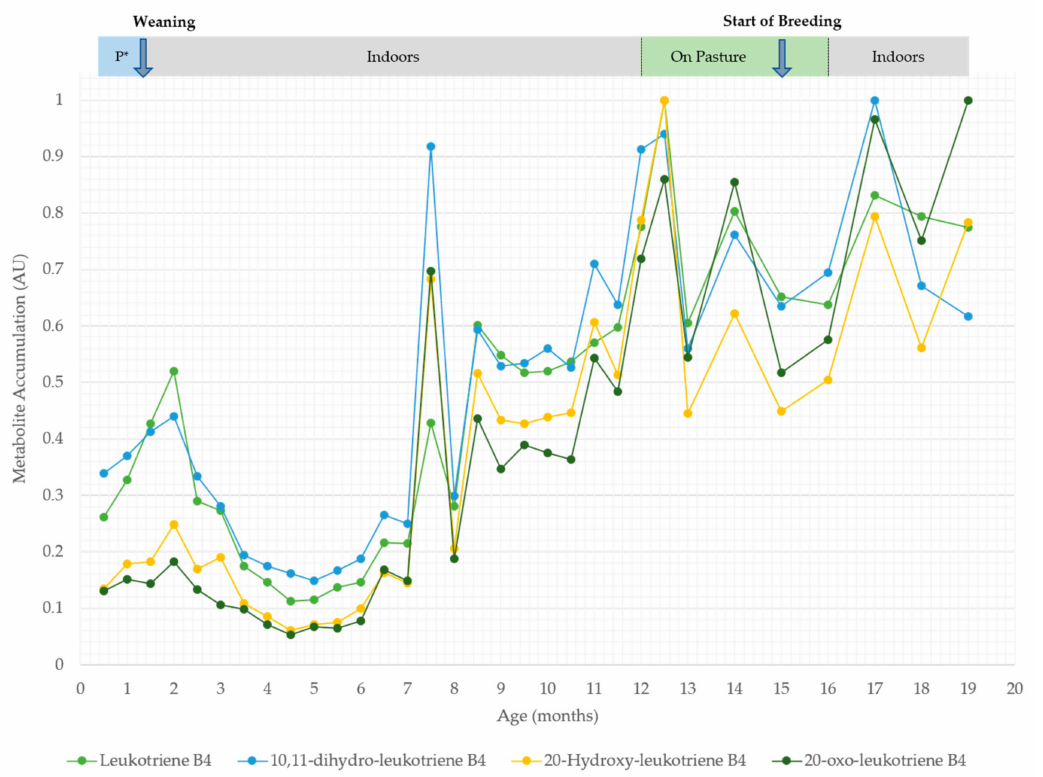
Figure 4. HCA of the major metabolite changes differentiating between HF heifers between 1 and 19 months of age in the combined ionization mode m/z . Changes in diet and/or environment are labelled accordingly, for example, P* = pre-weaning.